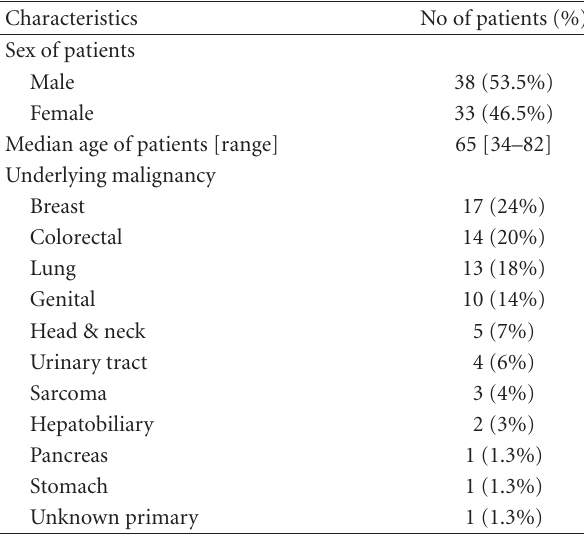
Table 3: Clinical characteristics of SSTI episodes.